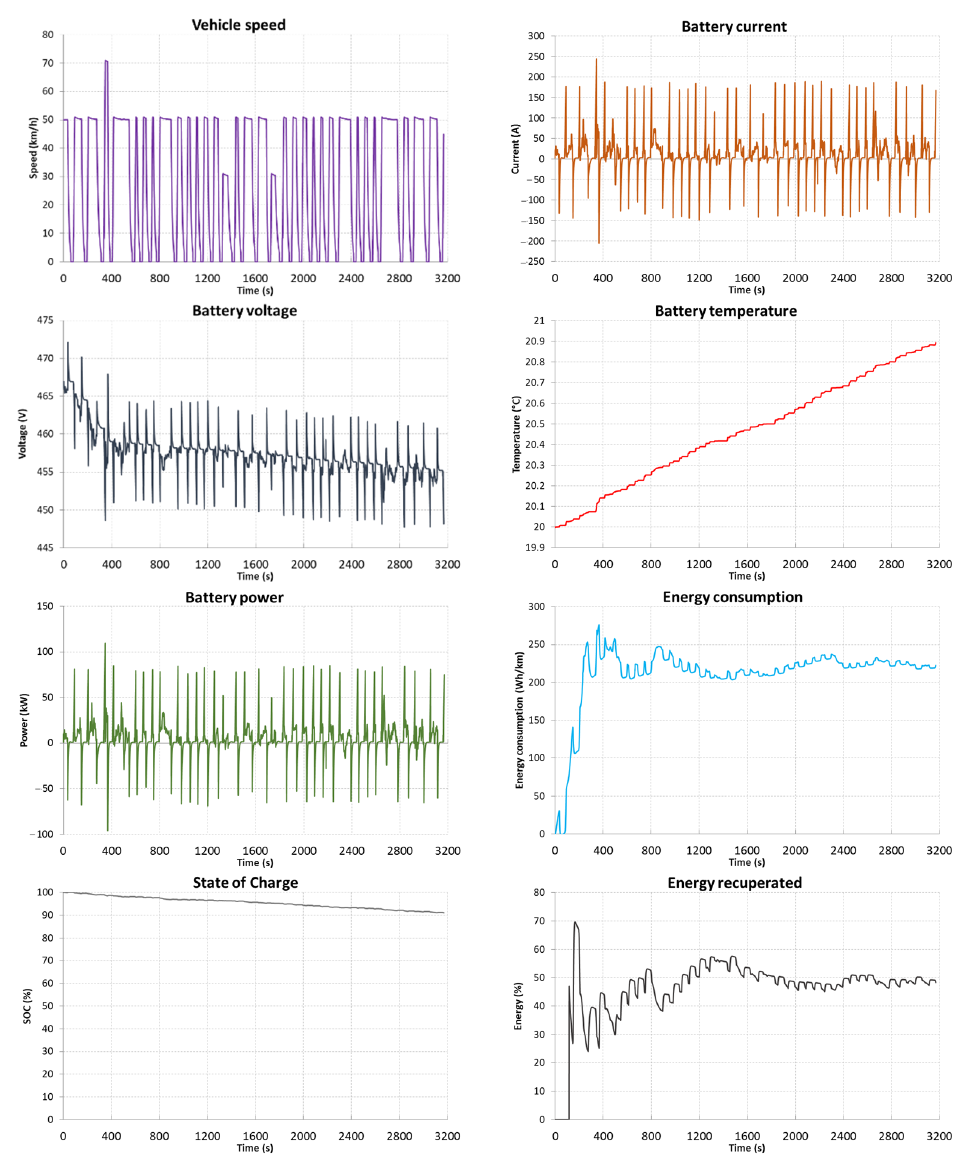
Figure 16. City Flat Road results of simulation tests for the 4 × 4 drive system with Type 2 energy storage.